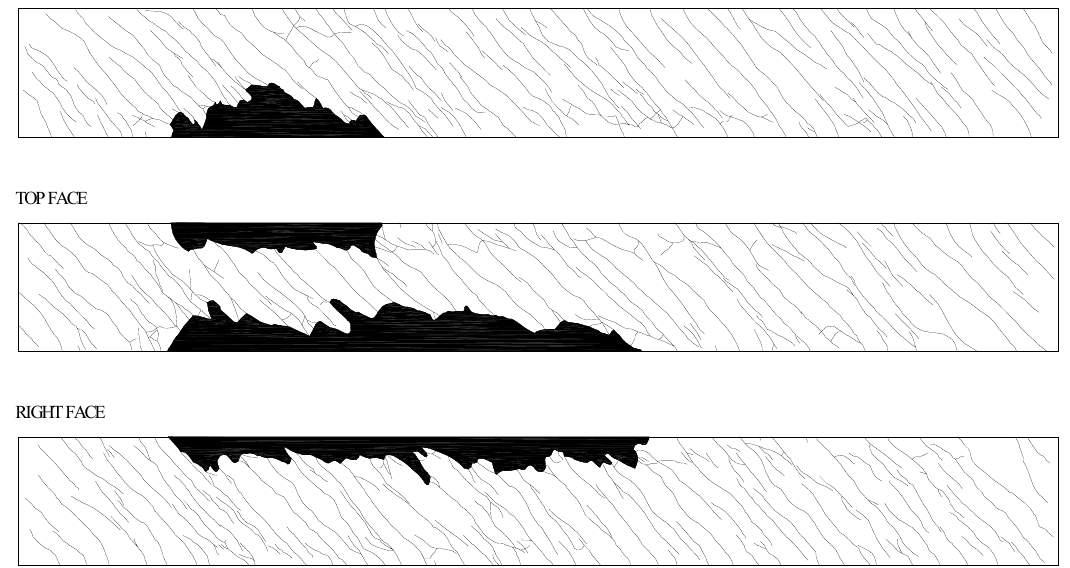
Appl. Sci. 2020 , 10 , x FOR PEER REVIEW Figure 13. Cracking pattern: Beam D-1.79. Figure 13. Cracking pattern: Beam D-1.79.